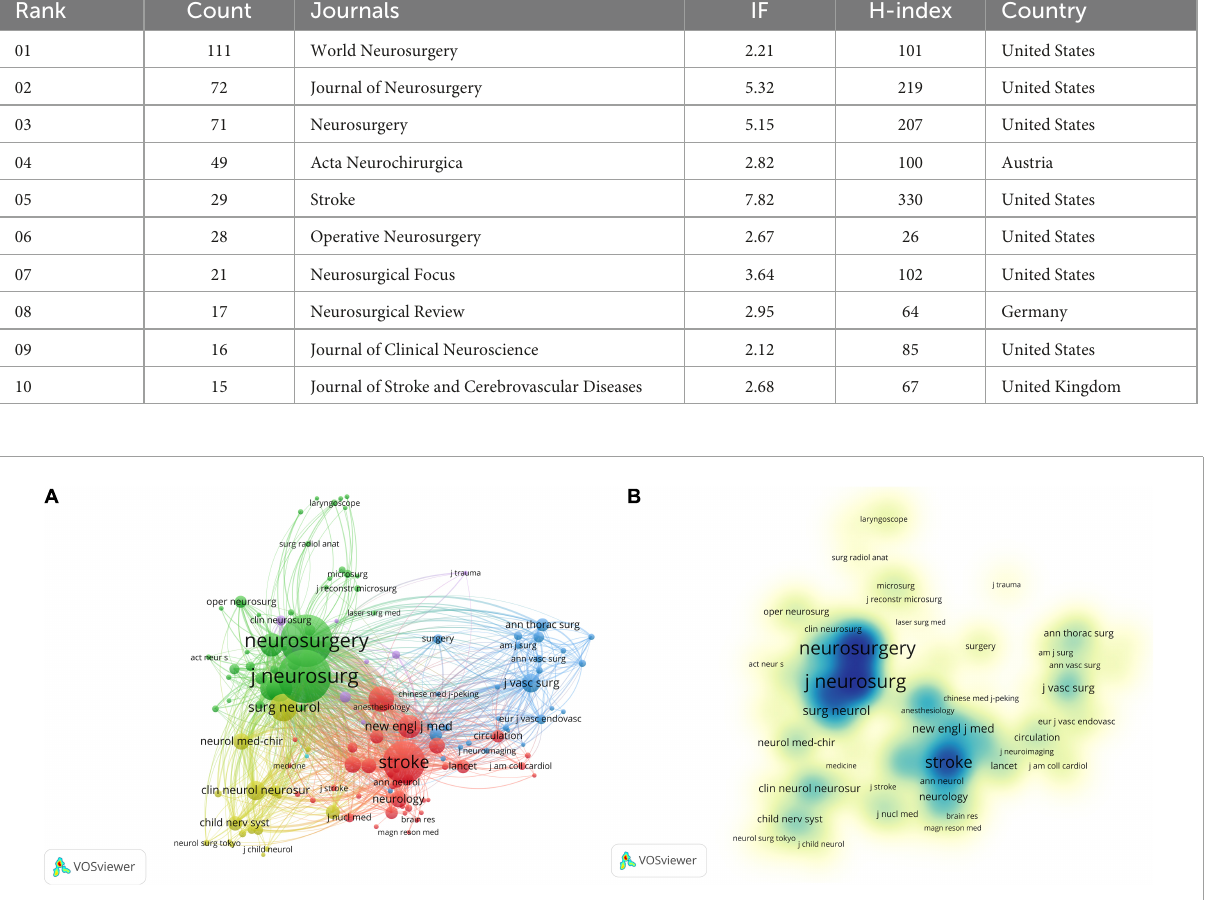
FIGURE6 Analysis of co-cited journals. (A) Network diagram of co-cited journals based on VOSviewer visual map. (B) Visualization of the density of co-cited journals based on VOSviewer visual map. Different color clustering reflects the cooperation between co-cited journals.